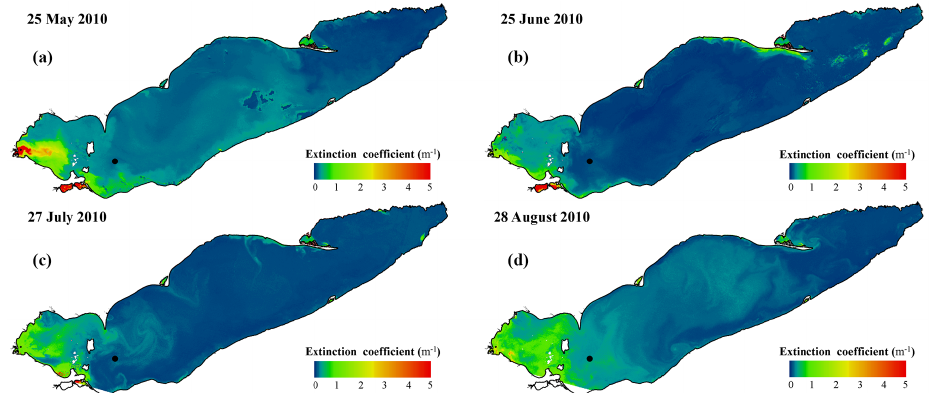
Figure 10. Temporal and spatial variation of satellite-derived K d in Lake Erie for different months of a year: May–August 2010. Location of the NDBC station is shown on the map as a solid dot.